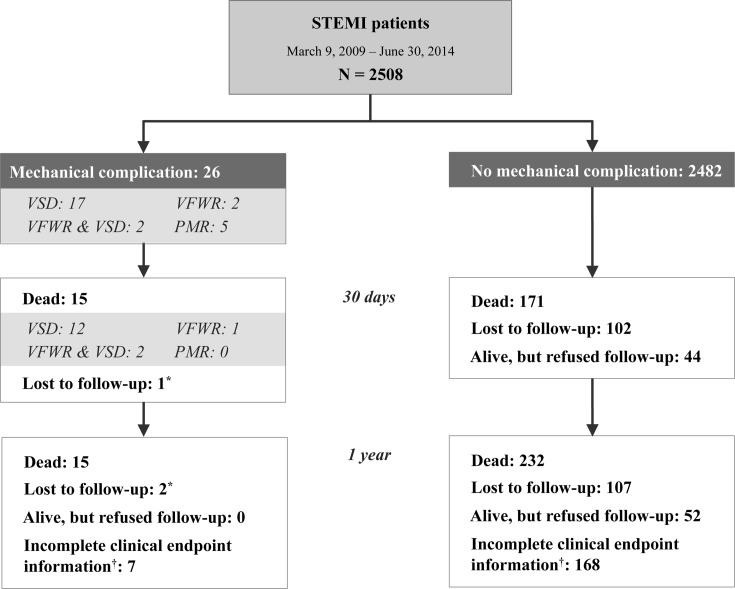
Study flowchart.2508 patients with ST-elevation myocardial infarction (STEMI) admitted for percutaneous coronary intervention at the University Hospital Bern between March 9, 2009 and June 30, 2014. 26 suffered a mechanical complication. STEMI, ST-elevation myocardial infarction; VSD, ventricular septal defect; VFWR, ventricular free wall rupture; PMR, papillary muscle rupture; * first patient lost to follow-up at day 26, second one at day 358; † regarding non-lethal clinical endpoints.